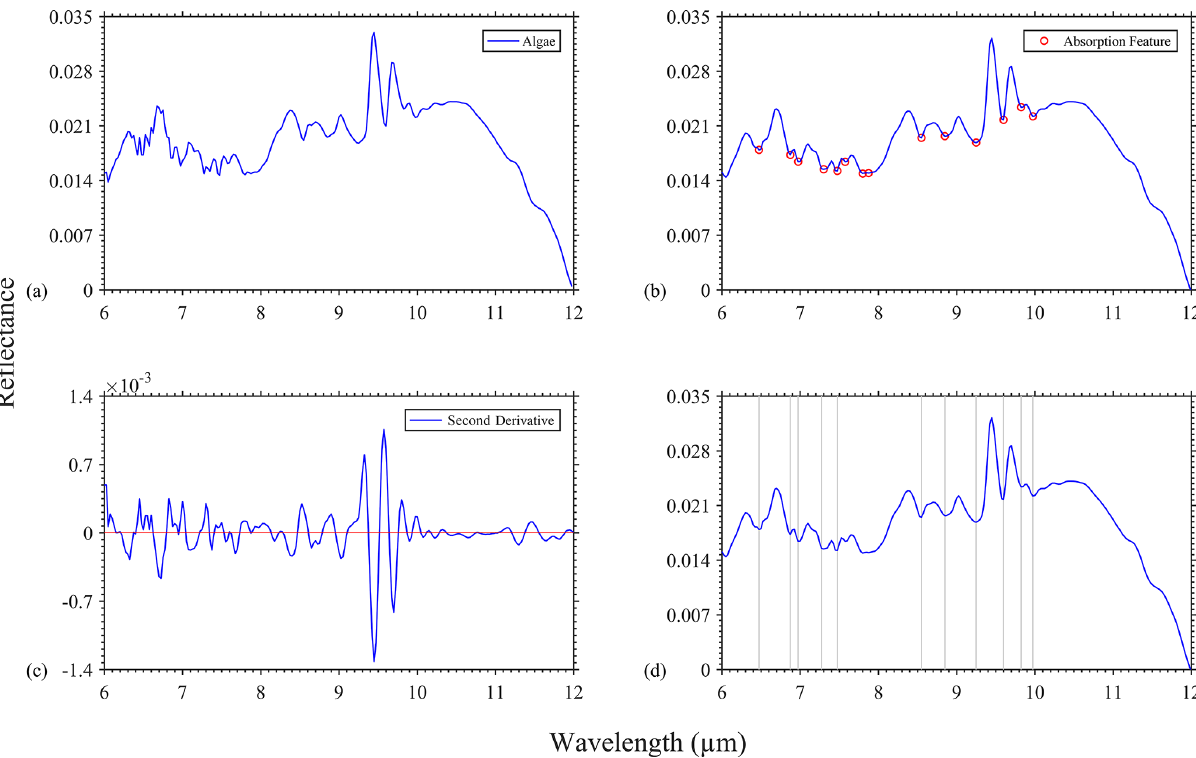
Figure 4. (a) Spectral reflectance of algae found along the shorelines of Punta Mallil-Cuem, Detif and Punta Apabón on the Chiloé Archipelago, Chile; (b) absorption features automatically picked; (c) second-derivative spectra; and (d) an end-member signal with the proposed diagnostic absorption features highlighted by the vertical